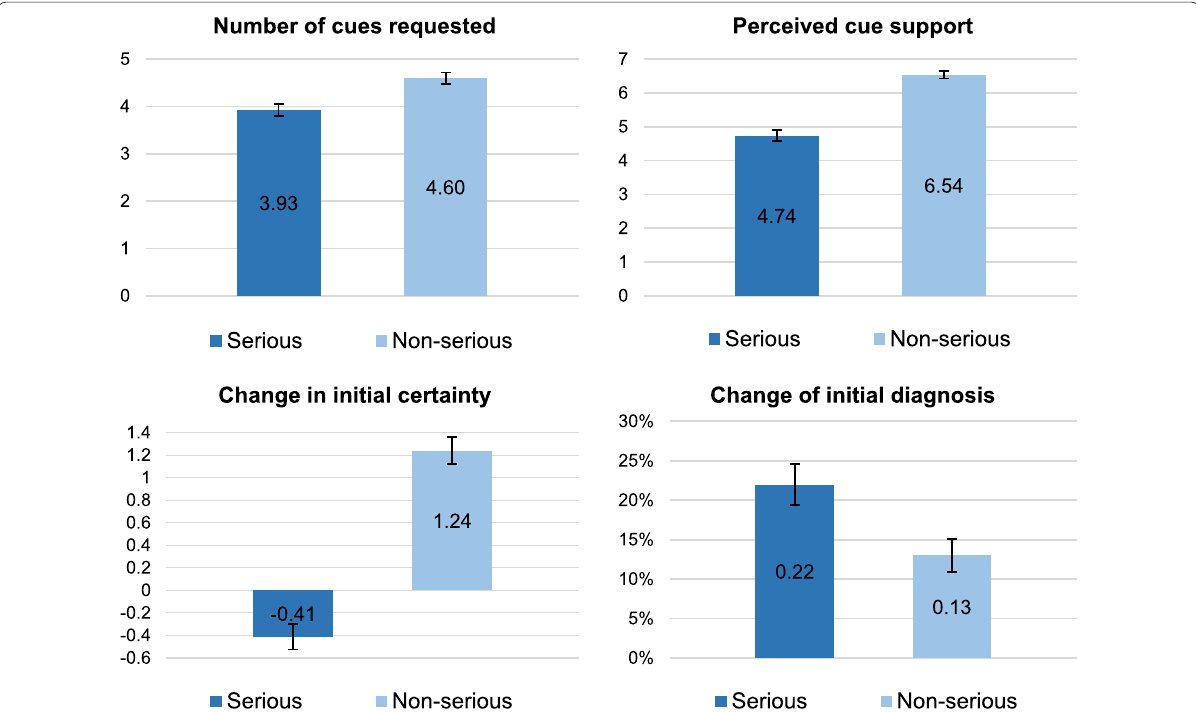
Fig. 3 Results of the variables of interest by severity of initial diagnosis. Top left panel: mean number of cue requests; Top right panel: mean perceived cue support (scale); Bottom left panel: mean change in initial certainty (scale); bottom right panel: percentage change of initial diagnosis following cue requests. All the differences were significant